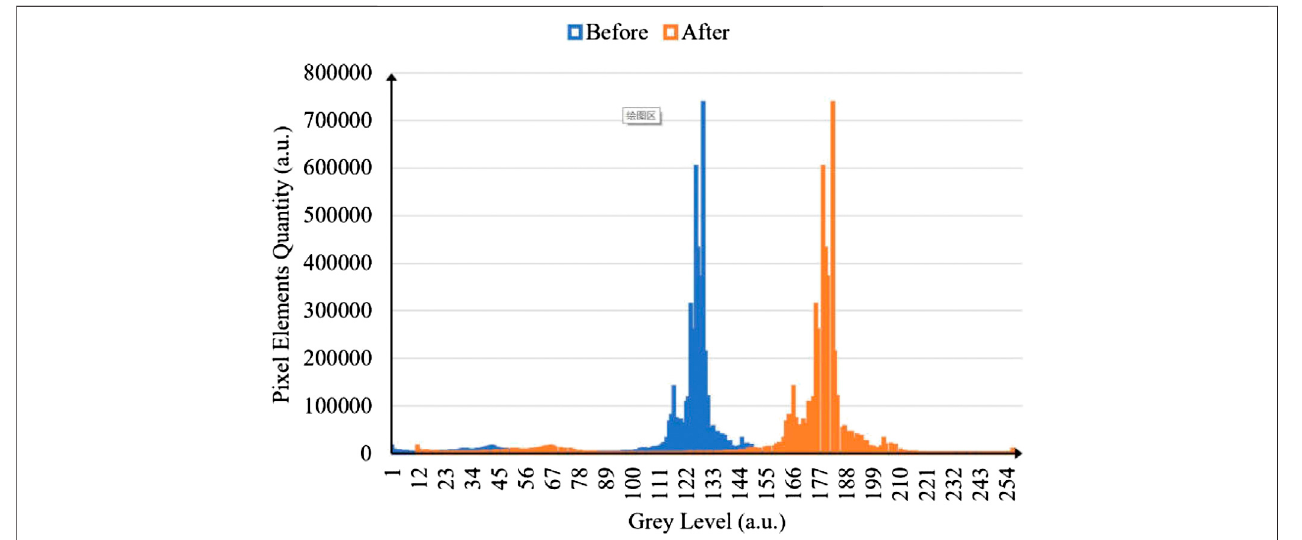
FIGURE 4 | Histogram comparison before and after normalized transformation, blue represents the gray level distribution of an image before the normalized histogram transformation, and yellow represents the transformed gray distribution